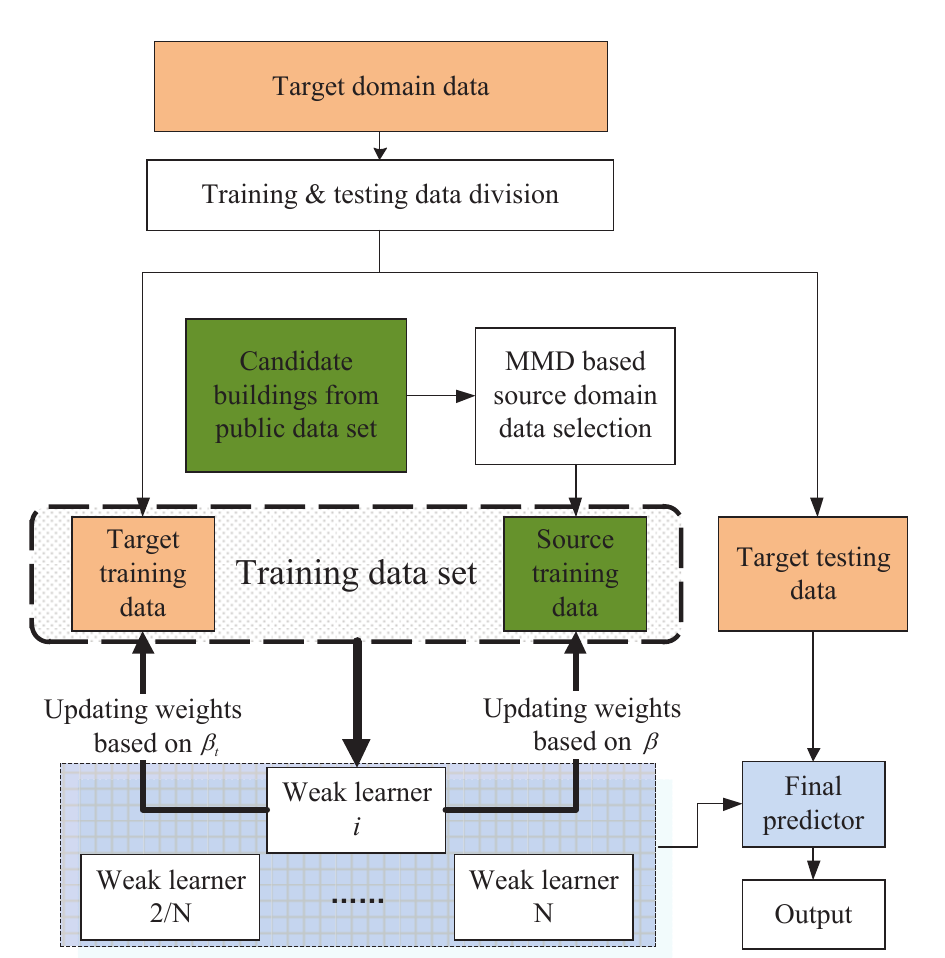
Figure 3. The overall